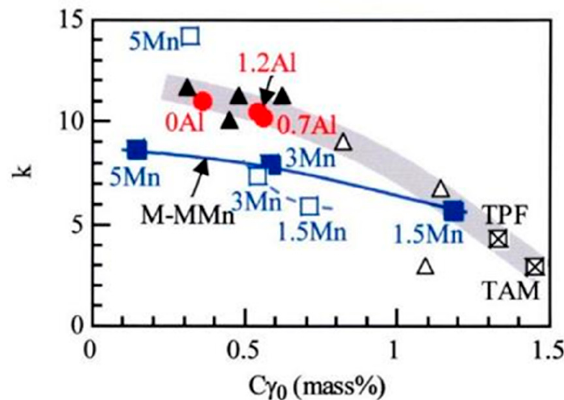
Figure 6. Relationships between strain-induced transformation factor ( k ) and initial carbon concentra- tion of retained austenite ( C γ 0 ) in 0.2C-1.5Si-1.2Mn-0.2Cr-(0.022-1.22)Al (0Al, 0.7Al, 1.2Al) TM steels ( ● ) [55,88], 0.2C-1.5Si-(1.5-5.0)Mn (1.5Mn, 3Mn, and 5Mn) M-MMn ( █ ) [59] and D-MMn ( □ )